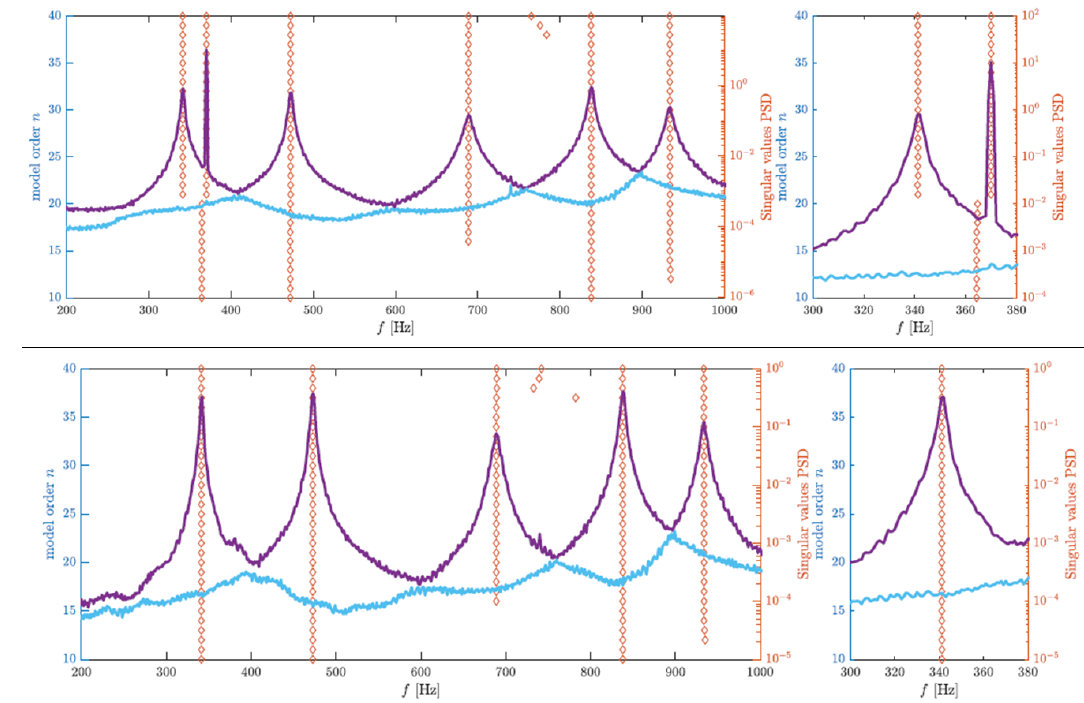
Figure 14. Stabilisation diagram of the signal after applying classical SSI (top) and KF-SSI (bottom). For orders lower than 20, SSI fails to distinguish between the structural mode and harmonic and presents a merged version, while KF-SSI exclusively identifies the structural mode (Gre´s et al., 2021).